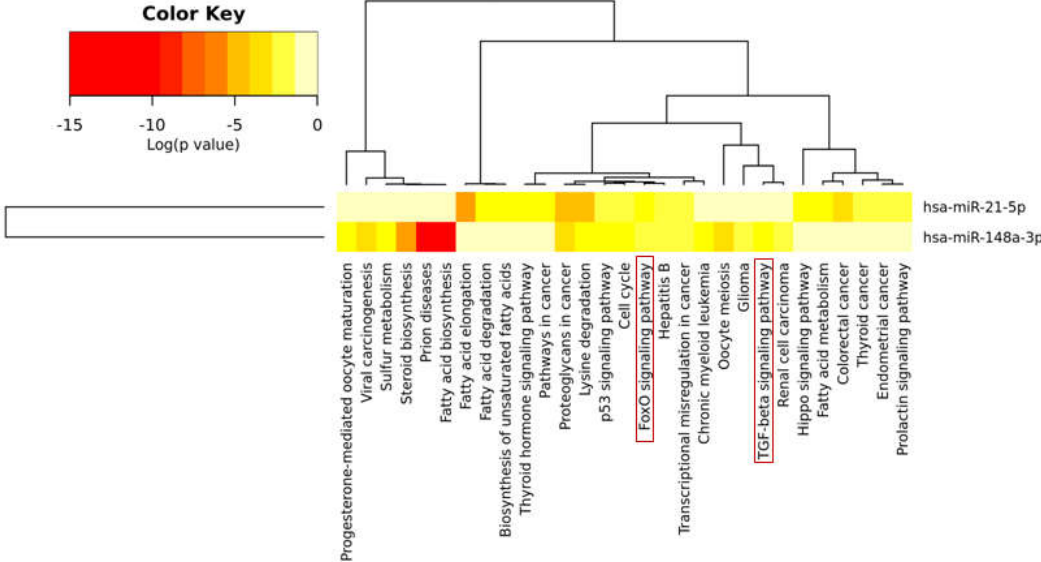
Figure 3. miR-148a and miR-21-5p regulate common pathways involved in bone metabolism and remodeling. Hierarchical Clustering Heatmap bioinformatic analysis of Kyoto Encyclopedia of Genes and Genomes (KEGG) pathways of hsa-miR-148a-3p and hsa-miR-21-5p target genes, showed FoxO and TGF- β signaling pathway as main pathways involved in bone metabolism and remodeling. Of note, FoxO signaling pathway is commonly identified both in miR-148a-3p and miR-21-5p analysis. Color key indicates Log p values from the less significant pathway ( light yellow ) to the most significant pathway ( dark red ).